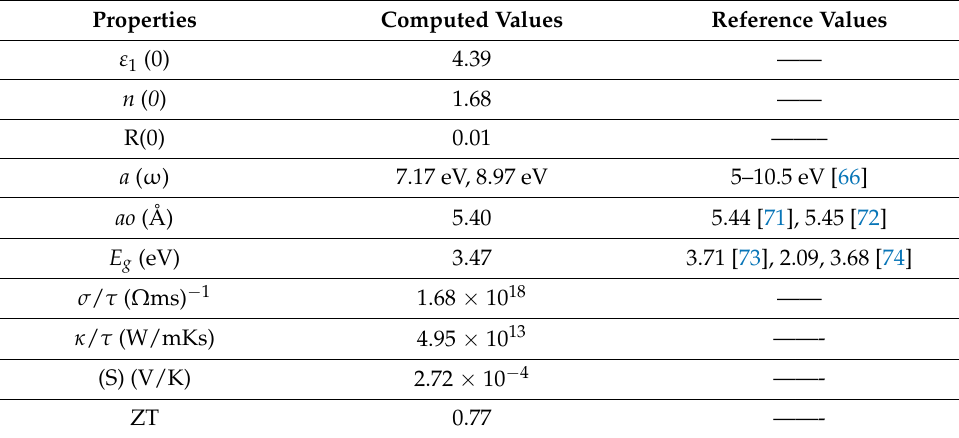
Table 3. Computed optical parameters, ao (Å) lattice constant, E g , and thermoelectric coefficients of ZnS at room